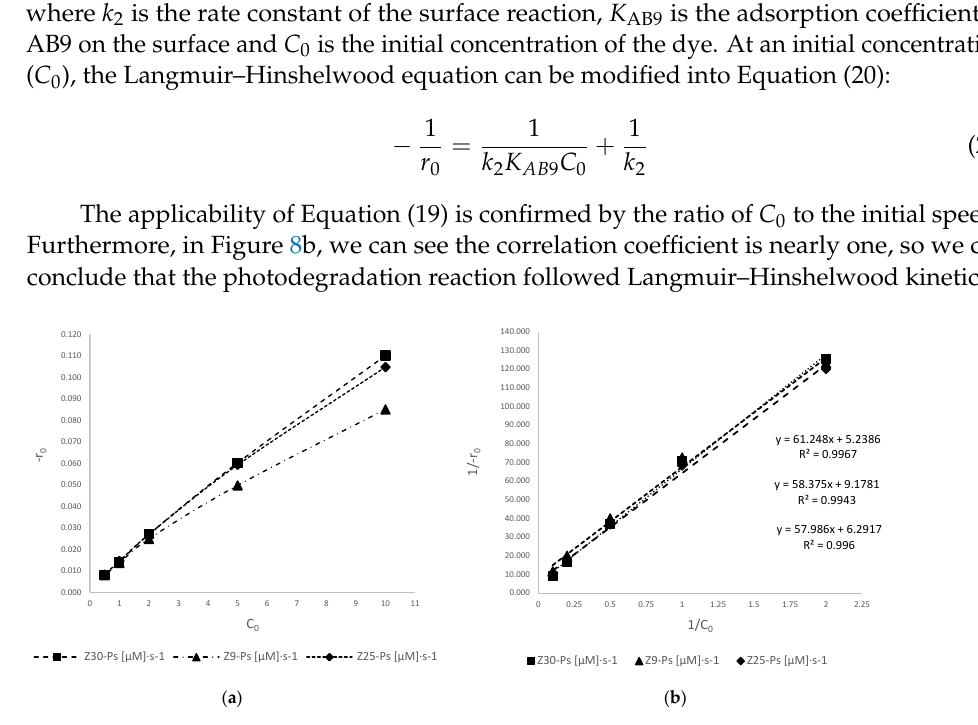
Figure 8. Trend of the initial speeds against the concentration of dye ( a , b ). The lines slope shows an inverse relationship with ZnO particle size and surface area. In the Figure 8b, Equation (20) is plotted, and the linearity obtained shows that the reaction occurs at ZnO ’s surface, where the organic species as well as the HO • radicals generated by catalyst UV irradiation are adsorbed [13]. The intersection of this straight line with the ordinate results in 1/k 2 . The adsorption equilibrium constant K AB9 was calculated from the slope. The kinetic constants obtained with the L – H model are compared with the particle sizes of the ZnO and reported in the table below (Table 3):